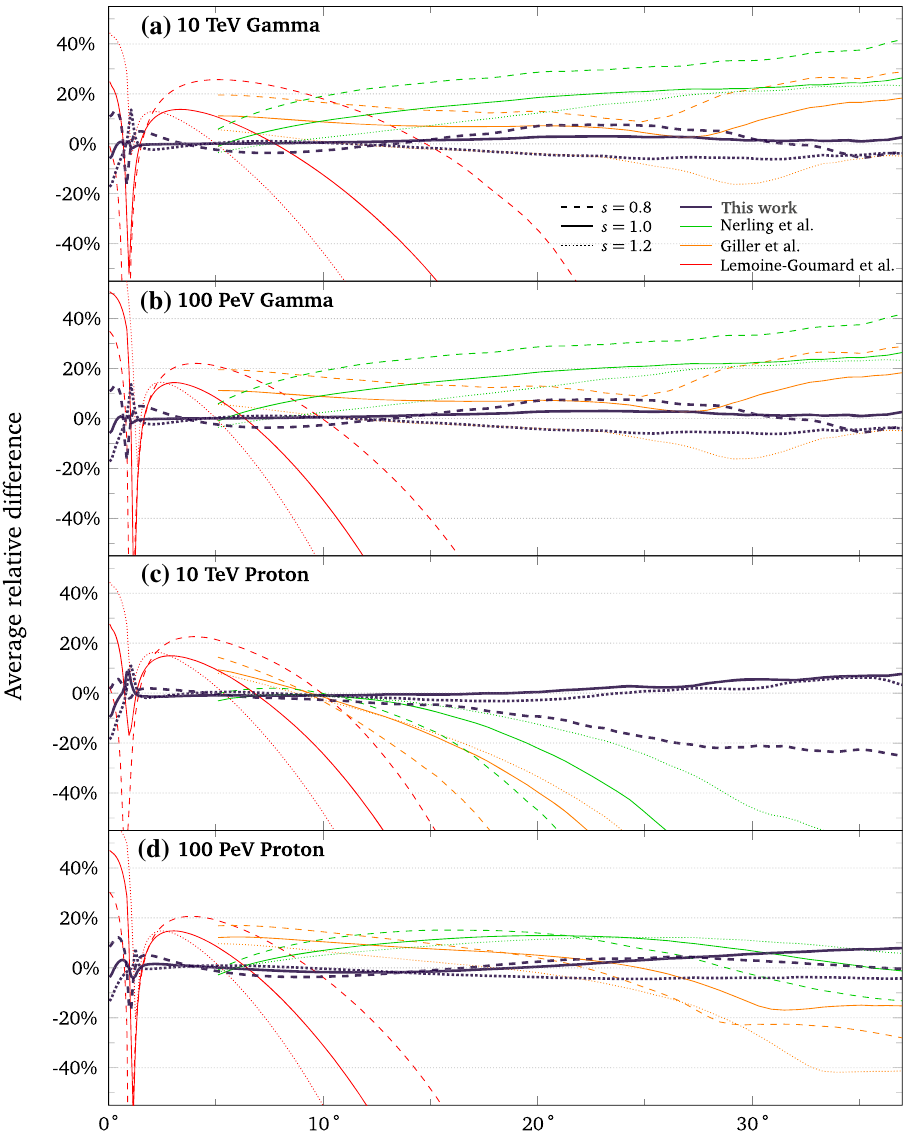
Fig. 5 Average relative deviation between parametrized and simulated angular distributions of Cherenkov photons at s = 0 . 8 (dashed curves), 1 . 0 (solid curves), and 1 . 2 (dotted curves). Each box depicts a single primary-energy combination, indicated in the top-left corner. Parametrization of this work is compared to predictions from Refs. [8,24,26] (see legend in the upper